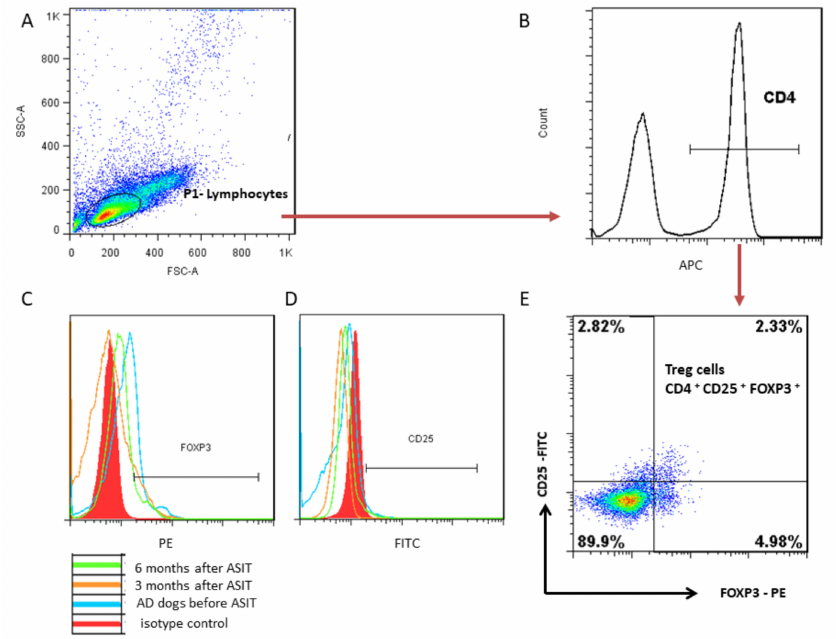
Figure 3. Representative plots of gating strategy for flow cytometry showing canine Treg characteri- zation. ( A ) Forward-scatter area (FS) versus side-scatter area (SS) plot to delineate the lymphocyte region. ( B ) The CD4 population was gated among lymphocytes. ( C , D ) Representative histograms of CD25 and FOXP3 expression, respectively, for AD patients before ASIT and 3 and 6 months after ASIT, with isotypic control marked on the histograms. ( E ) CD25 versus FOXP3 plot was used to gate Treg cells (CD4 + CD25 + FOXP3 + ) among CD4 + T cells. Data were analyzed using FlowJo